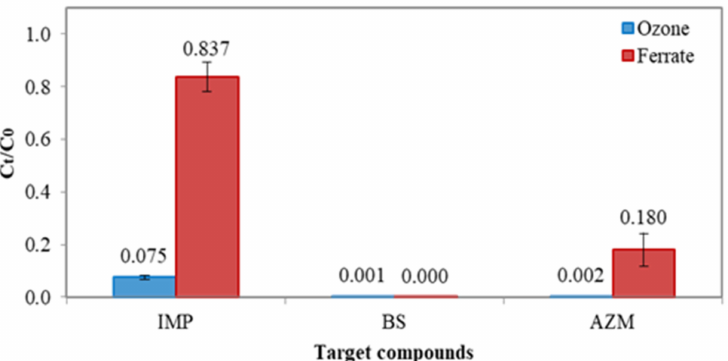
Figure 3. Mean concentration reduction of IMP, BS and AZM with ferrate(VI) and ozonation, respec- tively. The dosage of ferrate(VI) and ozone was 0.036 mM. Test solution concentration = 1000 µ g L − 1 and pH =